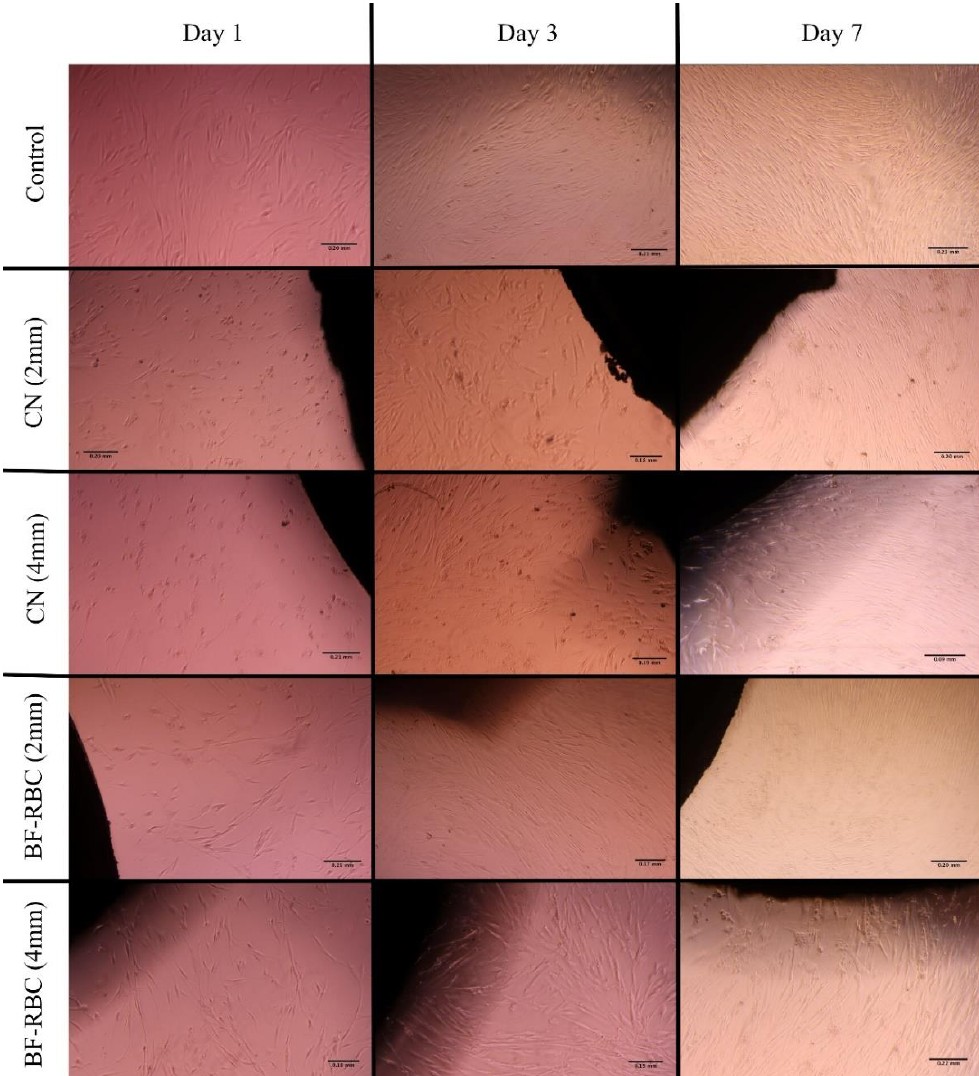
Figure 5. Microscopic images showing the morphological changes of the HGFCs for the different groups at days 1, 3, and 7.